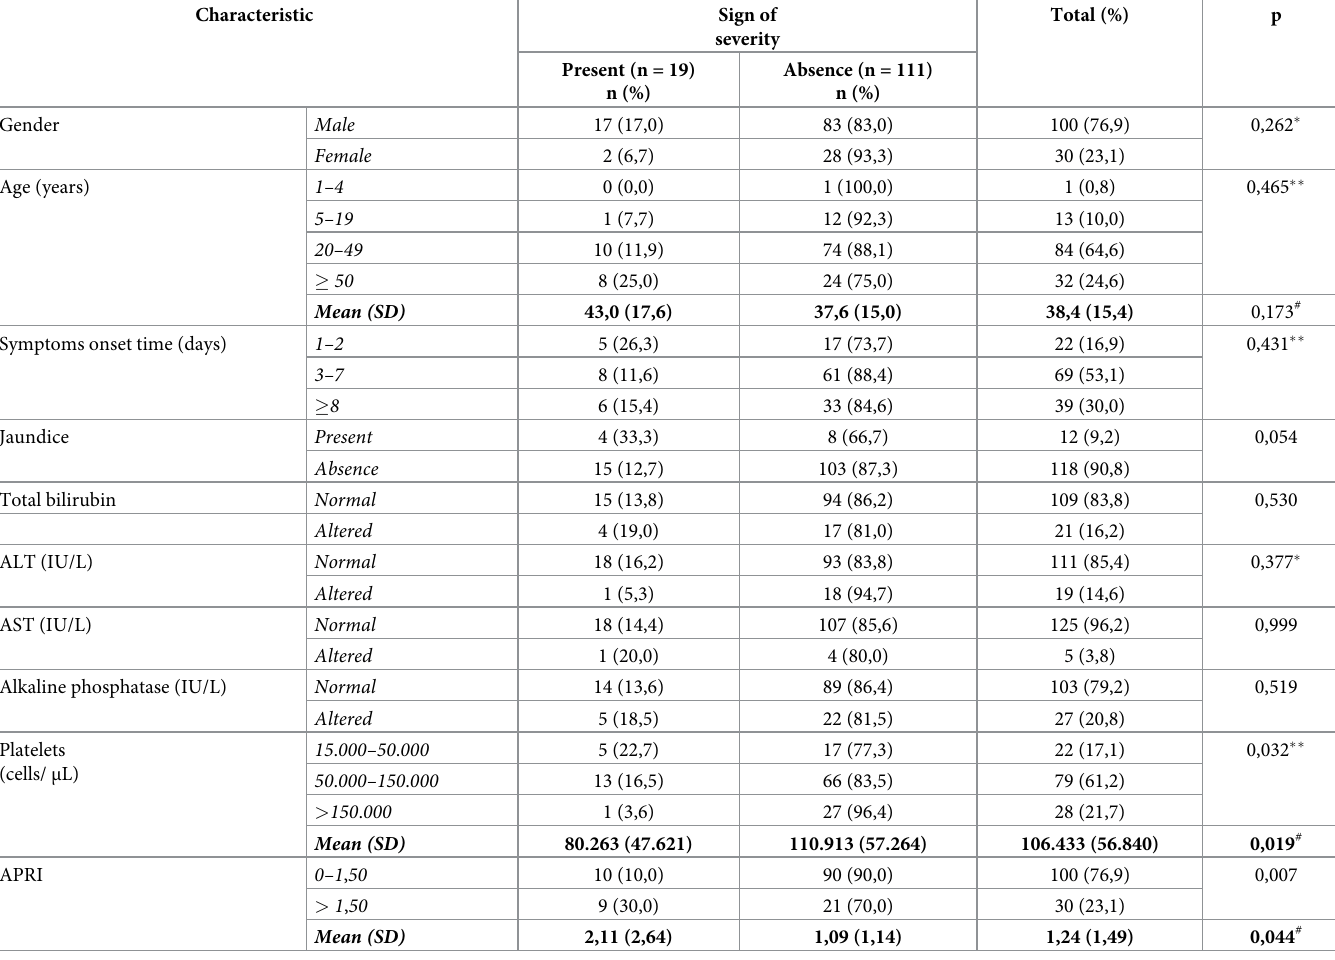
Table 1. Characteristics of the Plasmodium vivax infected patients, according to presence and absence of signs of severe vivax malaria.